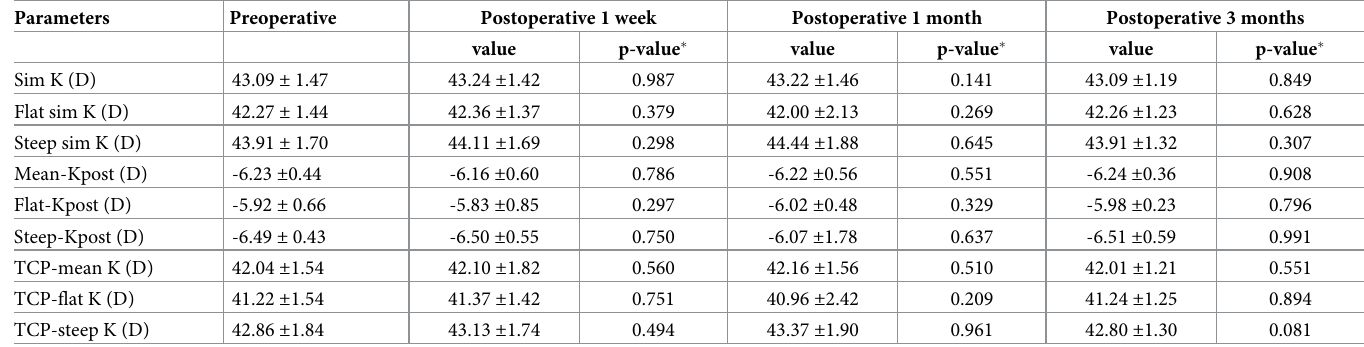
Table 4. Comparison of preoperative and postoperative data on corneal structure in group B.